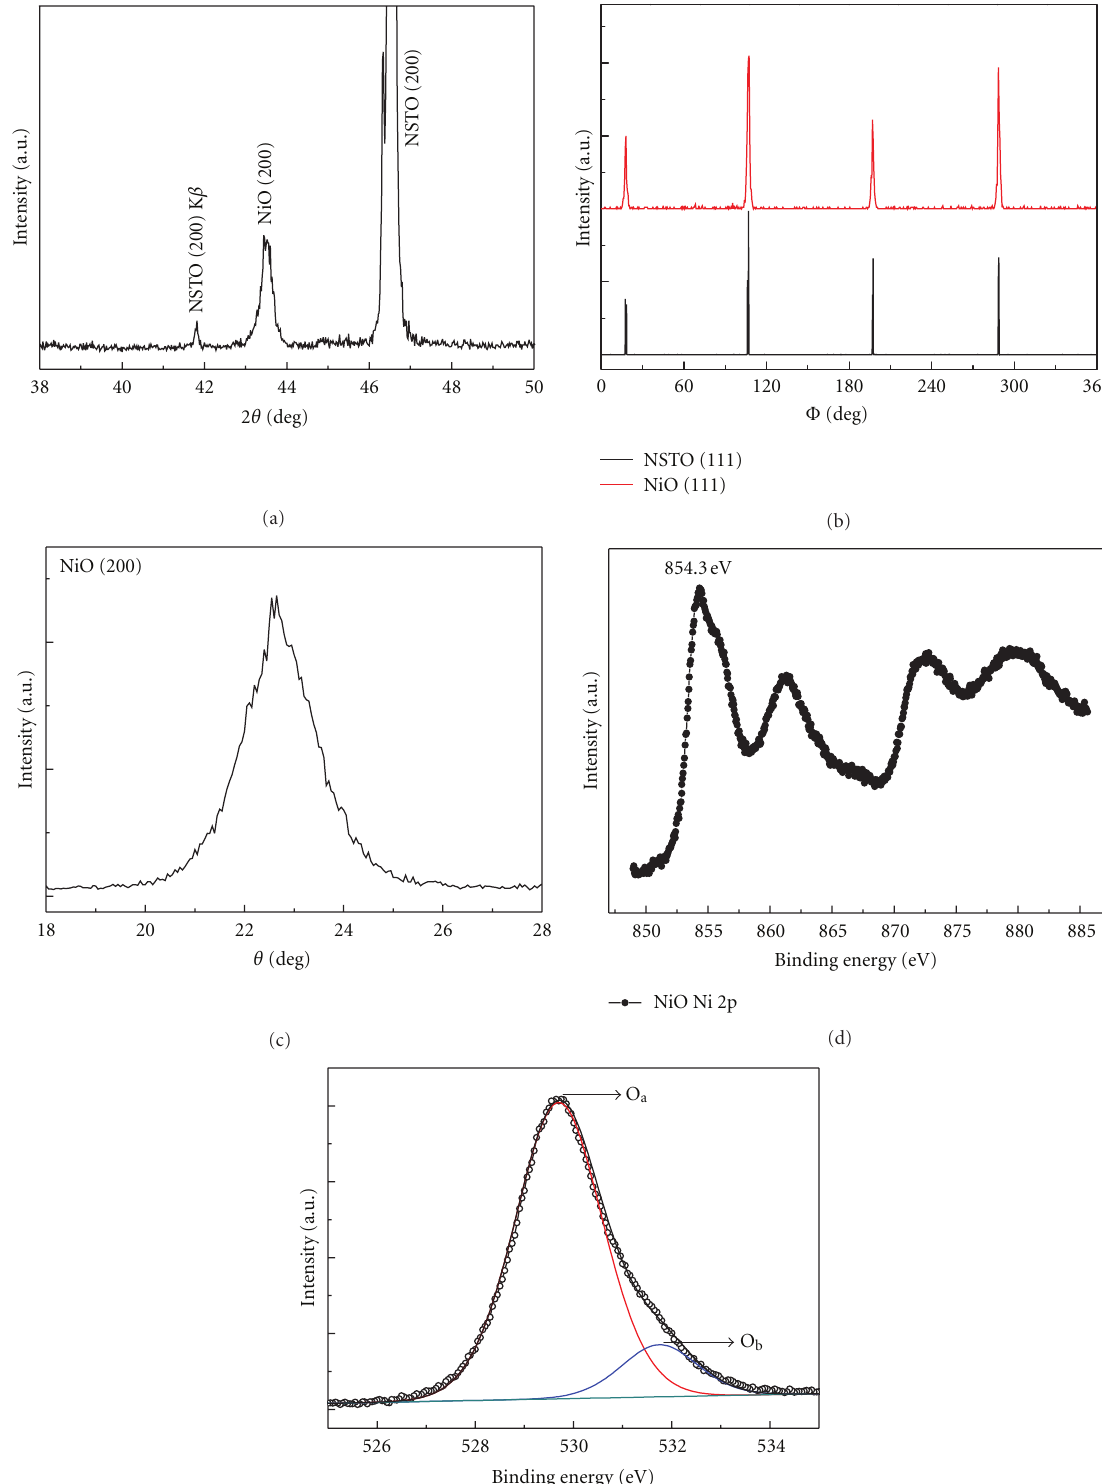
Figure 1: The XRD patterns for NiO/NSTO in θ -2 θ scan (a) and Φ -scans of NiO (111) and NSTO (111) planes (b). Rocking curve scans of 200 peak for NiO (c). Typical XPS spectra of the NiO film for Ni 2p (d) and O1s